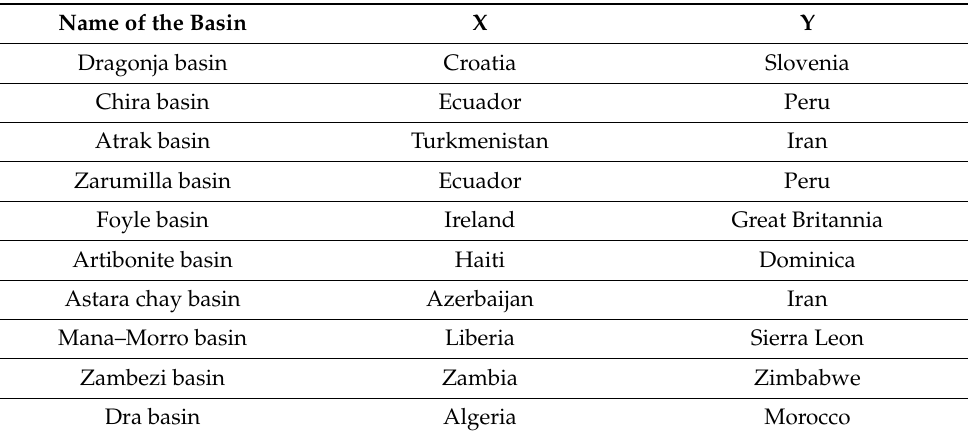
Table A2. Objective cases that can environmentally embrace HSA2.